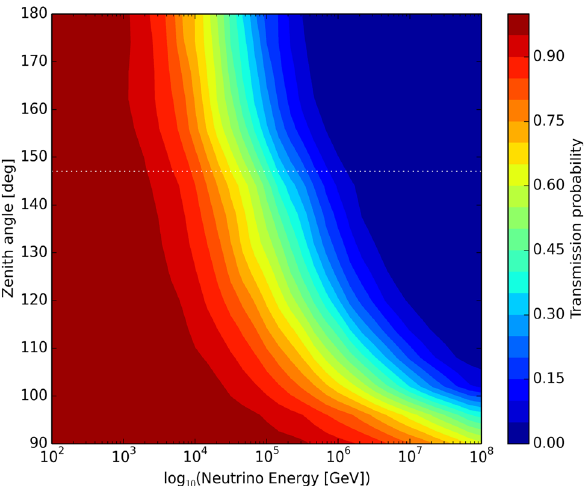
Fig. 13 Transmission probability assuming the Standard Model neutrino-nucleon cross section for neutrinos crossing the Earth, as a function of energy and zenith angle. Neutral-current interactions are included. The horizontal white line shows the location of the core- mantle boundary. Figure from [97]